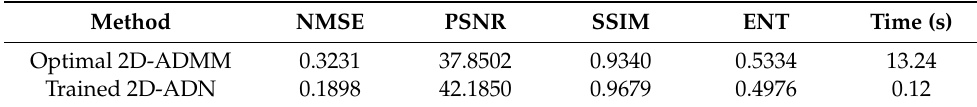
( h ) Figure 21. Images of 2D ‐ ADN at different stages: ( a )